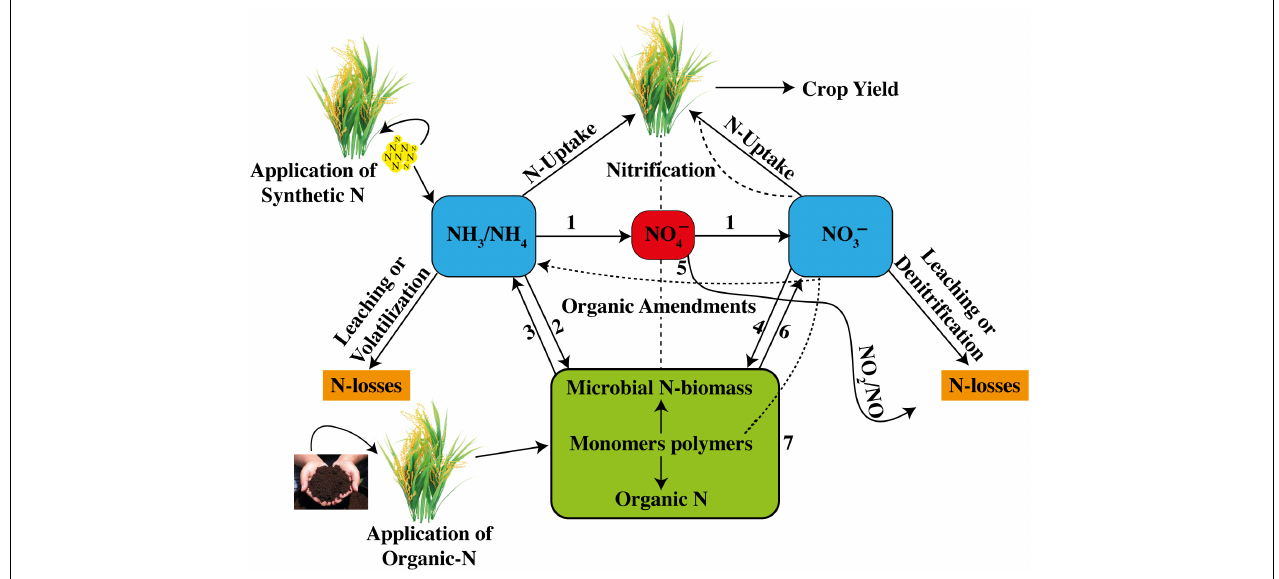
FIGURE 1 | Internal soil N-cycling is comprised of nitrification, ammonification, NH 4 + -immobilization, NO 3 – -immobilization, dissimilatory NO 3 – reduction to NH 3 (DNRA), heterotrophic nitrification, and plant N uptake (taking reference of Norton and Ouyang,